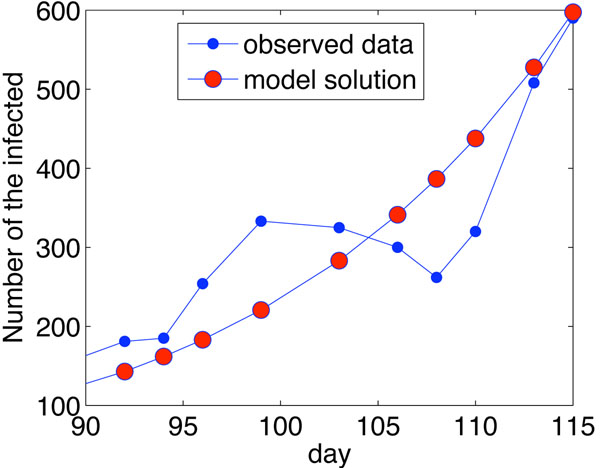
Observed data and model simulation. Observed data and model simulation of the number of infected individuals. The minimum degree is 3 and maximum degree is 100.